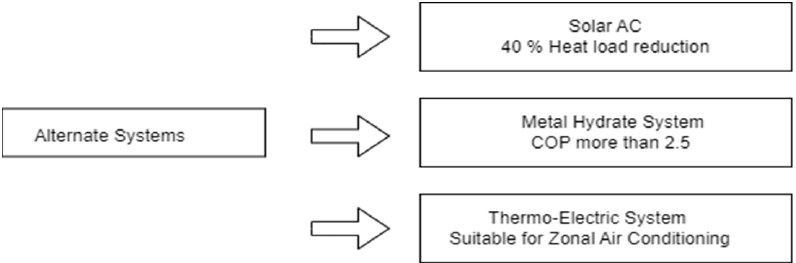
Figure 3. Different automotive AC systems and their advantages.